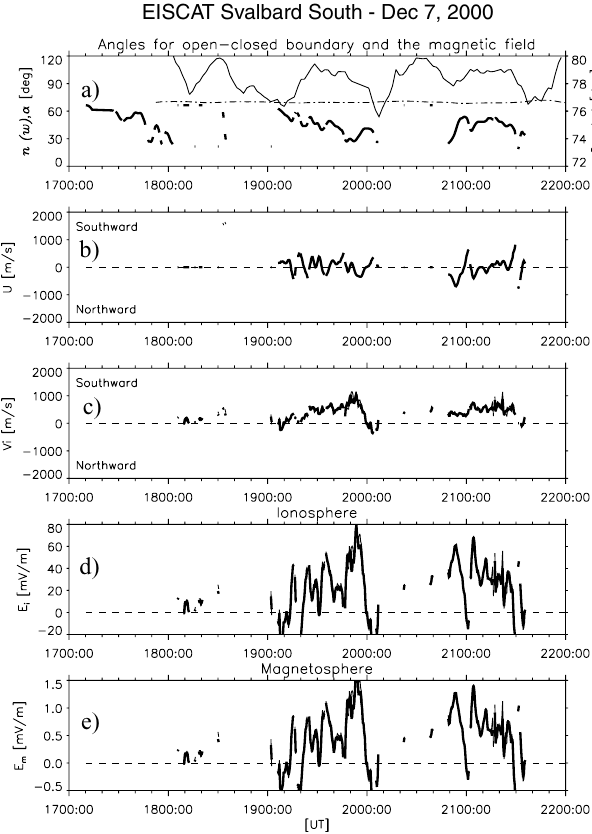
Fig. 9. Same as Fig. 5, but for the EISCAT Svalbard radar on 7 December 2000. Time resolution is 26s.